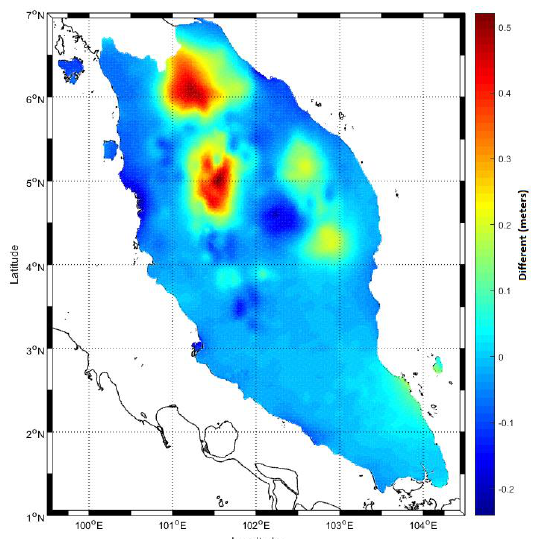
Figure 10 Difference between the two geoid at land region